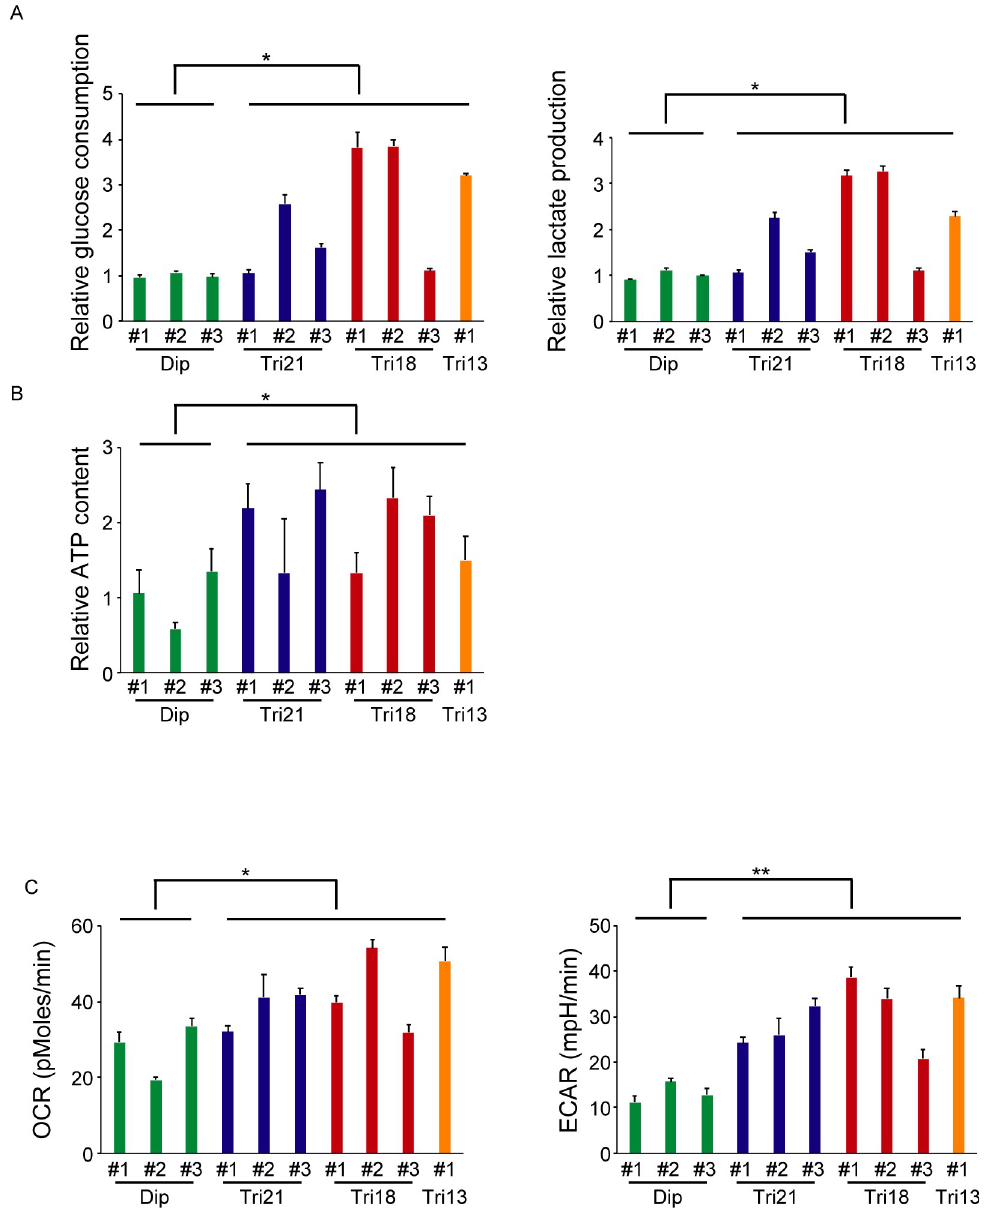
Fig 3. Senescent trisomy fibroblasts showed increased glucose consumption and increased lactate production, suggesting disturbed energy metabolism. (A) The left panel shows relative glucose consumption by 1 × 10 5 cells over three days, as assessed by decreased glucose content in the culture medium. The right panel shows relative lactate production by 1 × 10 5 cells over three days, as assessed by increased lactate content in the culture medium (n = 3 per cell line). � P < 0.05. Dip, diploid; Tri, trisomy. (B) Relative cellular ATP content, as assessed by an intracellular ATP determination kit (n = 4 per cell line). � P < 0.05. Dip, diploid; Tri, trisomy. (C) The left panel shows oxygen consumption rate (OCR), as assessed by an XF96 Extracellular Flux Analyzer. � P < 0.05. The right panel shows extracellular acidification rate (ECAR), as assessed by an XF96 Extracellular Flux Analyzer (n = 3–6 per cell line). �� P < 0.01. Dip, diploid; Tri, trisomy. Comparisons were made by Student’s t-test or Welch’s two-sample